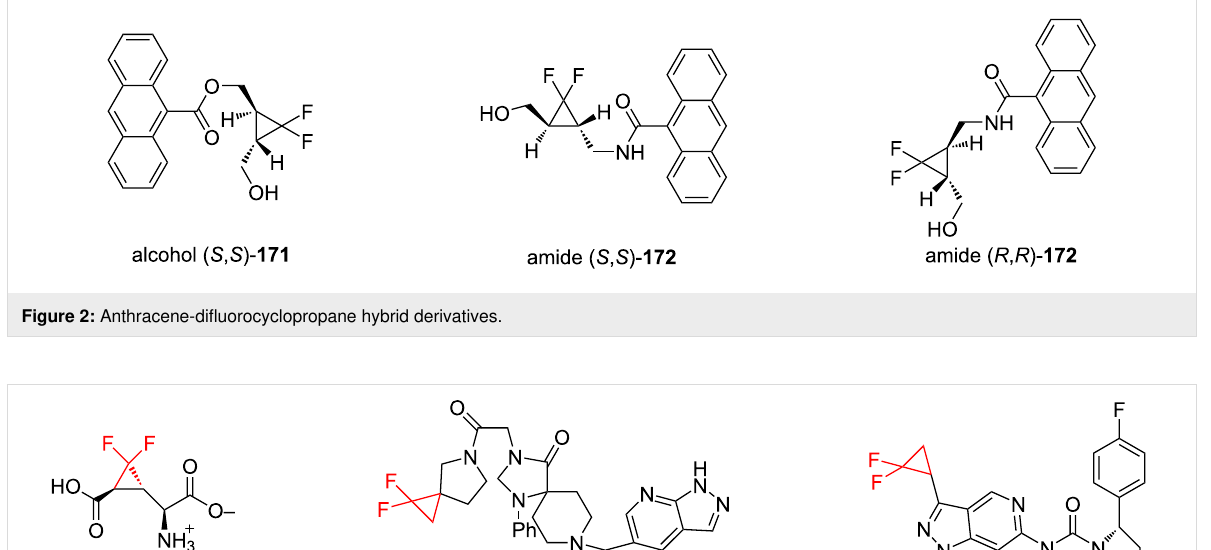
metabotropic glutamate receptor 2 with